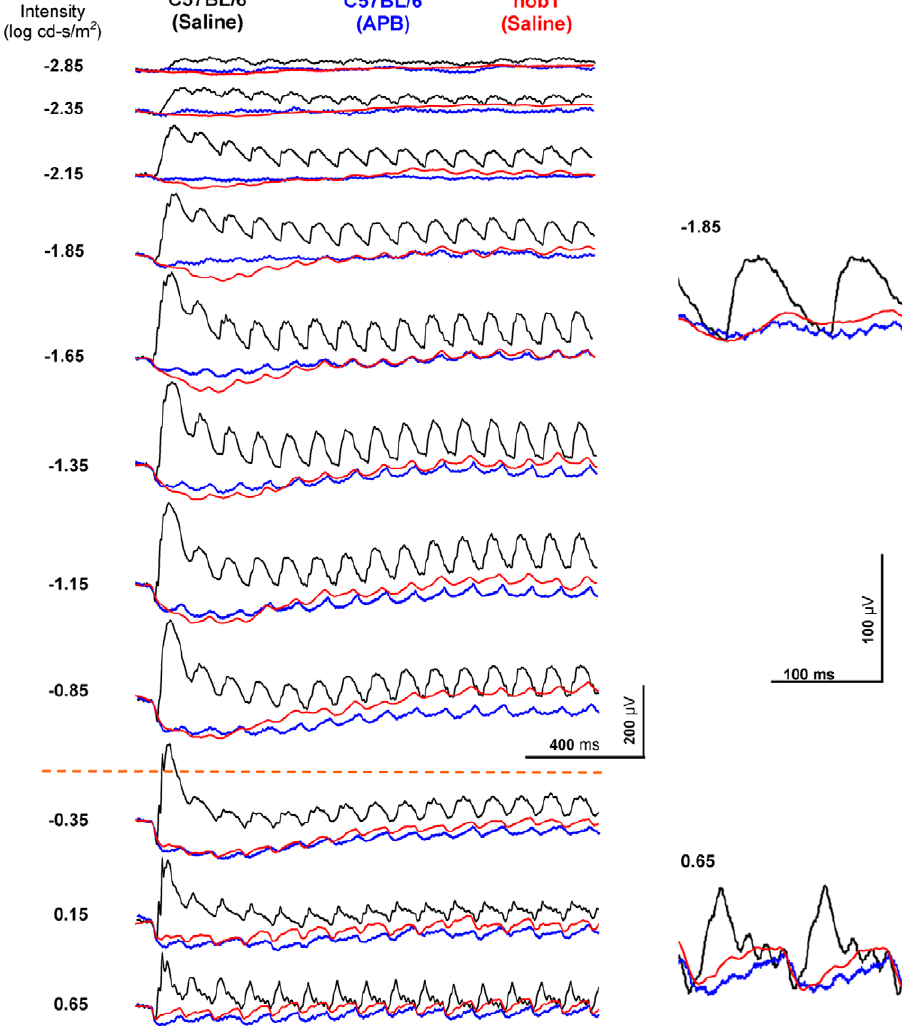
Figure 5. Dark-adapted 10-Hz flicker ERG OFF pathway responses in mice. The black traces show the ERGs from a saline-injected eye and the blue traces show the ERGs from the contralateral APB-injected eye of a C57BL/6 mouse. The red traces show the flicker ERGs from a saline-injected eye of a nob1 mouse. The saline-injected eye of the wild-type mouse presents normal rod- and cone-driven flicker responses. The APB-injected C57BL/ 6 mouse eye and the saline-injected nob1 mouse eye show similar ERGs. The flicker response amplitudes decrease and the thresholds increase. In the APB-injected C57BL/6 mouse and in the saline-injected nob1 mouse, residual flicker responses ( , 20% of the control) persist at intensity levels where signals are rod- or